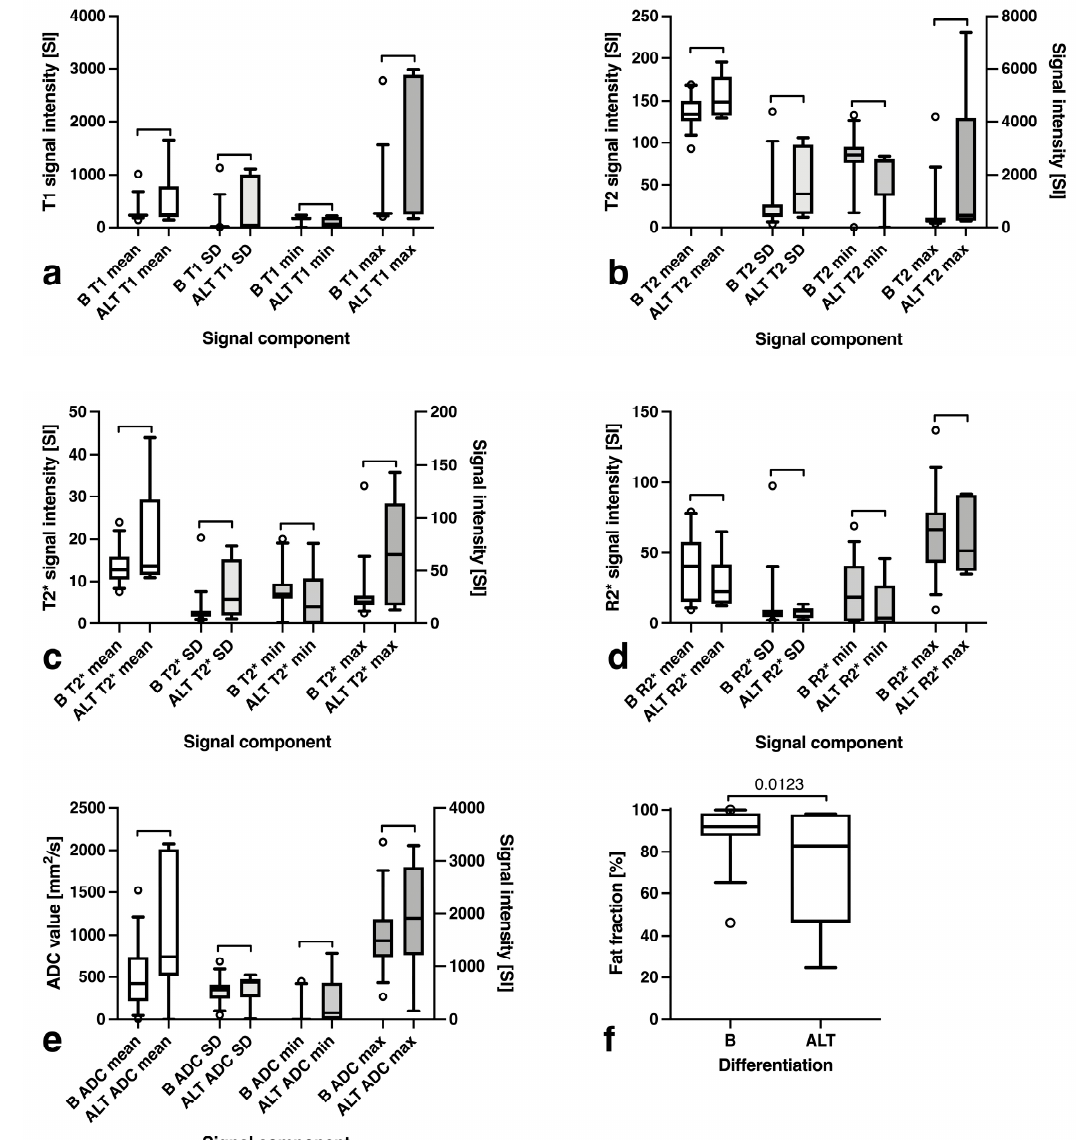
Figure 6. ( a ) Comparison of T1w, ( b ) T2w, ( c ) T2*, ( d ) R2* and ( e ) ADC signal intensity values as well as ( f ) fat fractions for benign (B) tumors and atypical (ALT) lipomatous tumors (ALT). Outliers are depicted as circles. Based on this predictor ranking, a score based on maximum (cut-off 125.5 mm) and orthogonal second-largest diameter (cut-off 39.5 mm), contrast enhancement, maximum septation thickness (cut-off 1.3 mm) and intratumoral fluid accumulation without surround- ing fluid was developed. The benign lesions showed a significantly lower average score of 1.4 (95% CI 1.1 to 1.7) compared to the ALT score of 4.3 (95% CI 3.5 to 5.2; p < 0.0001) (Figure 7a) for ROC AUC of 0.99 ( p = 0.0001) and opposite distributions of B and ALT lesions along increasing score numbers ( p < 0.0001; Figure 7b). The correct classification rate at a cut-off of 3 or greater was 95.7% (sensitivity, 100.0 [61.0 to 100.0%], specificity, 94.9 [83.1 to 99.1%], likelihood ratio,